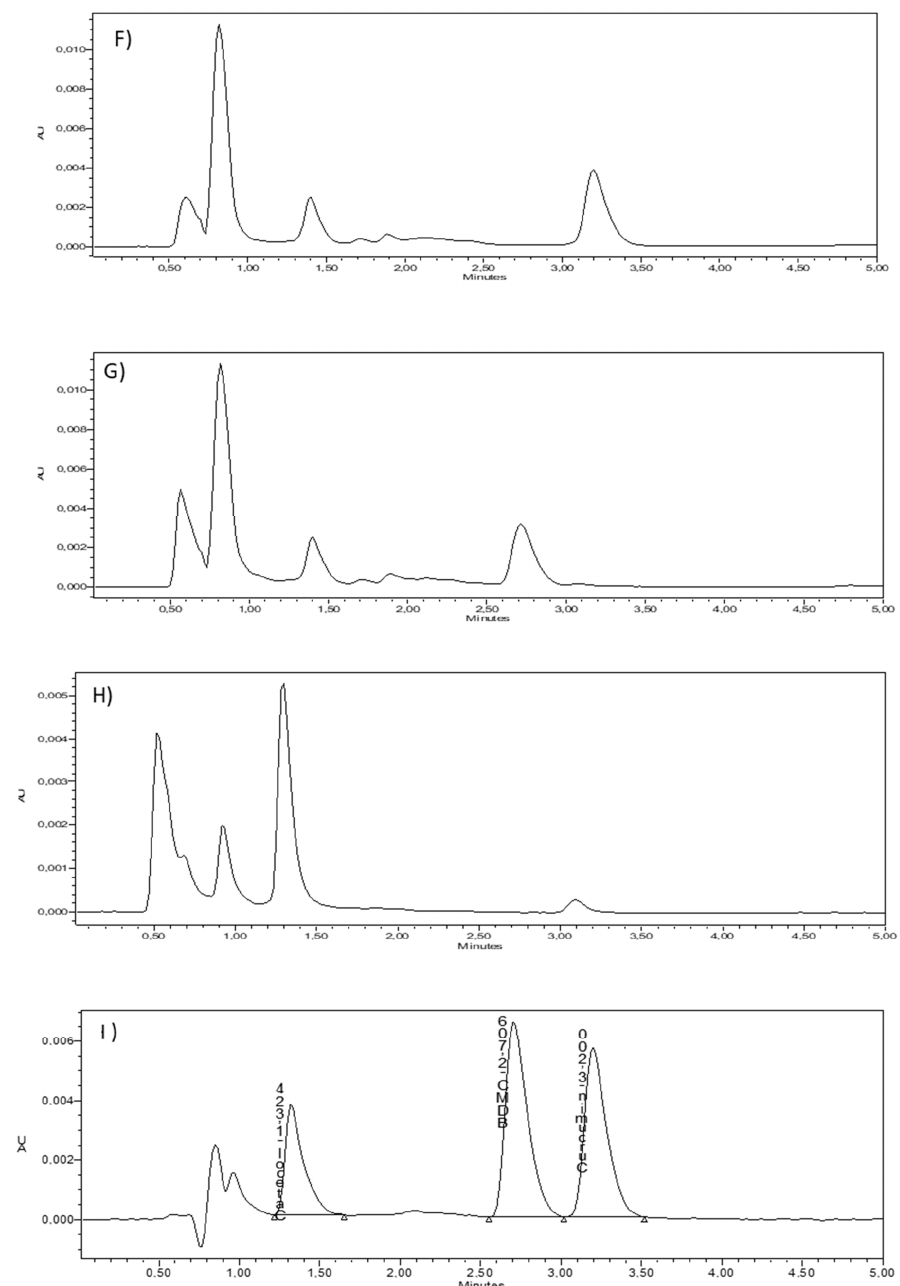
Figure 3. HPLC chromatograms. ( A ) blank sample (DMSO); ( B ) CUR in solution; ( C ) CUR retained in the skin; ( D ) BDMC in solution; ( E ) BDMC retained in the skin; ( F ) CAT in solution; ( G ) CAT retained in the skin; ( H ) HPLC chromatogram of the mixture of the three curcuminoids, CUR, BDMC and CAT; and ( I ) chromatogram of the three curcuminoids extracted from the skin. To prove the selective detection of the curcuminoids, even in presence of other compo- nents from biological samples, the curcuminoids in solution were placed in contact with human skin for 24 h at 32 ◦ C to promote their penetration and were then extracted again by immersing the tissue in an appropriate solvent and under sonication. DMSO was used for extracting CUR and BDMC, while the mobile phase was used for extracting CAT because DMSO shows an absorption signal close to the retention time of this compound. The chro- matograms showing the individual curcuminoids CUR, BDMC and CAT extracted from the tissue can be observed in Figure 3D,F and H, respectively, showing no signals in